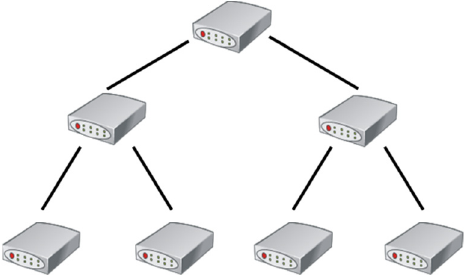
Figure 1. Schematic diagram of tree topology.